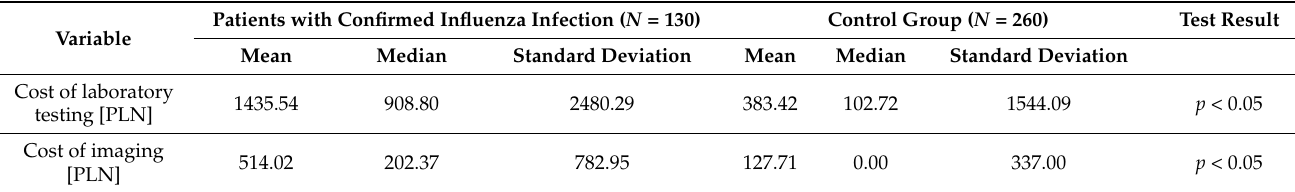
Table 1. The main hospitalization indicators for the hospital patients with confirmed influenza infection and for the control group (1 PLN = 0.22 EUR).